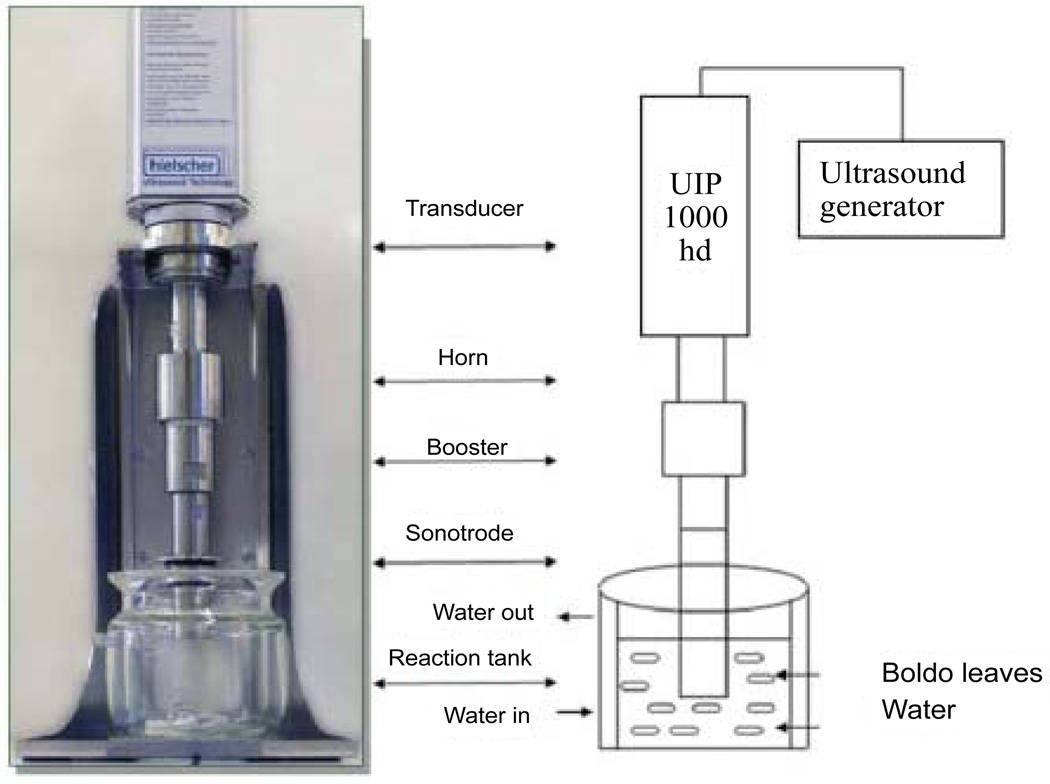
Ultrasound-assisted extraction (UAE) method [31].